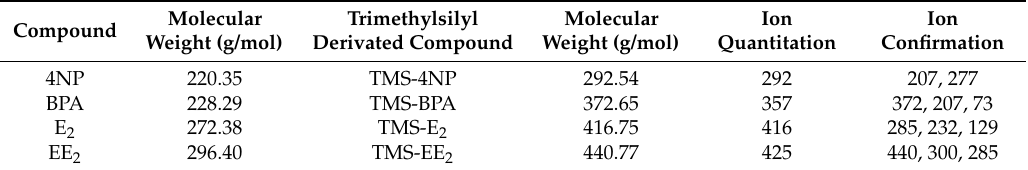
Table 1. Monitored ions ( m / z ) in mass spectrometry for each of the trimethylsilyl derivated (TMS) compounds of interest.